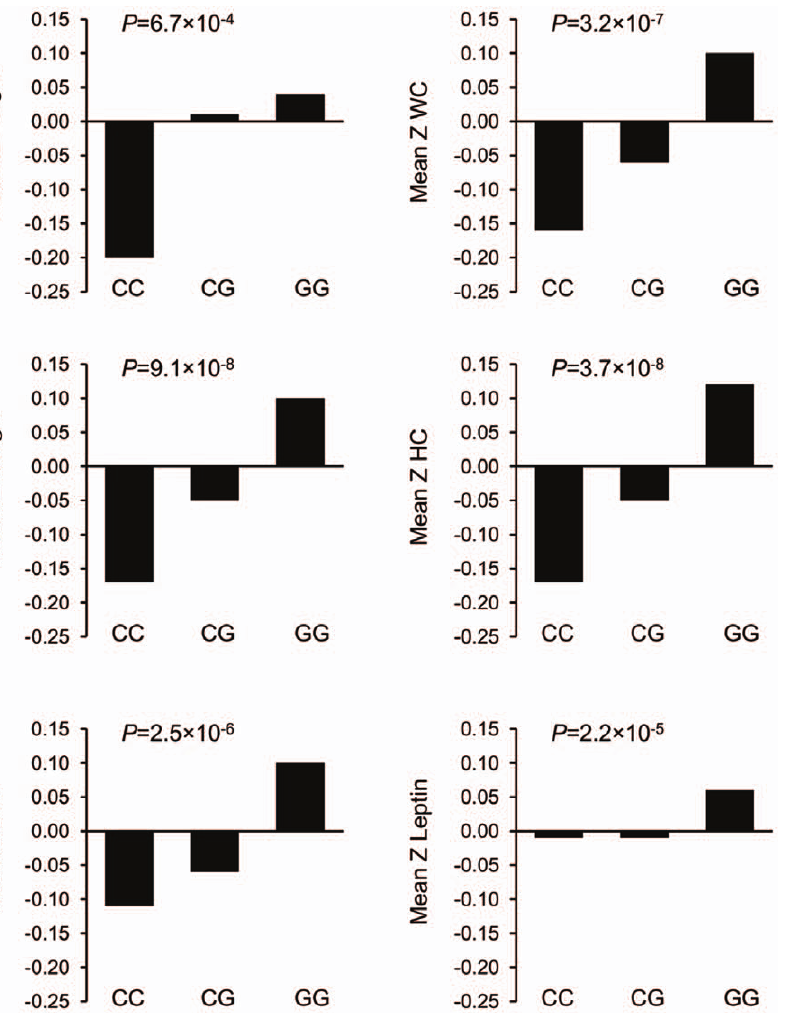
Figure 2. Association of rs2796749 with clinical traits in urban Indian children. Mean Z-scores adjusted for age and sex are plotted on the y-axis for the corresponding genotypes on x-axis for all the traits except leptin for which the mean Z-scores are adjusted for age, sex and Z-BMI. P values presented were determined by linear regression analysis for Z-score change per risk allele of the respective trait.